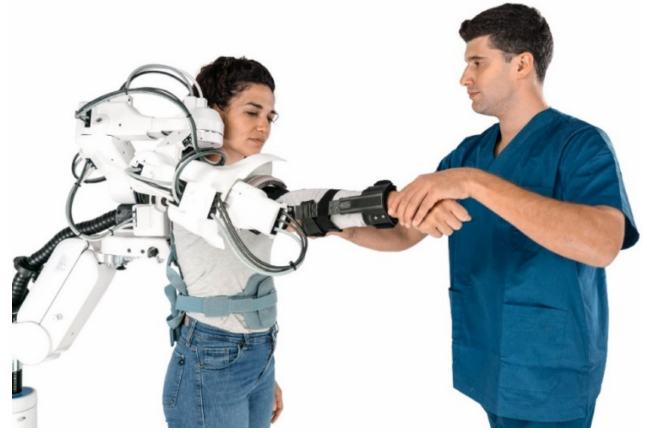
Figure 8. Repeat Trajectory mode. Therapist interacting with the machine and the patient to show the movement to be recorded.